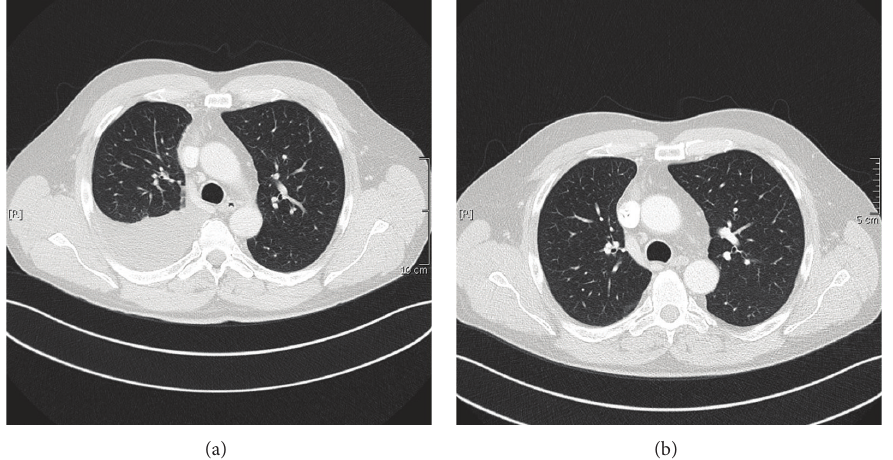
Figure 2: (a) Tumor manifestation before the systemic chemotherapy, (b) partial remission of the tumor in the right lung after 6 cycles of